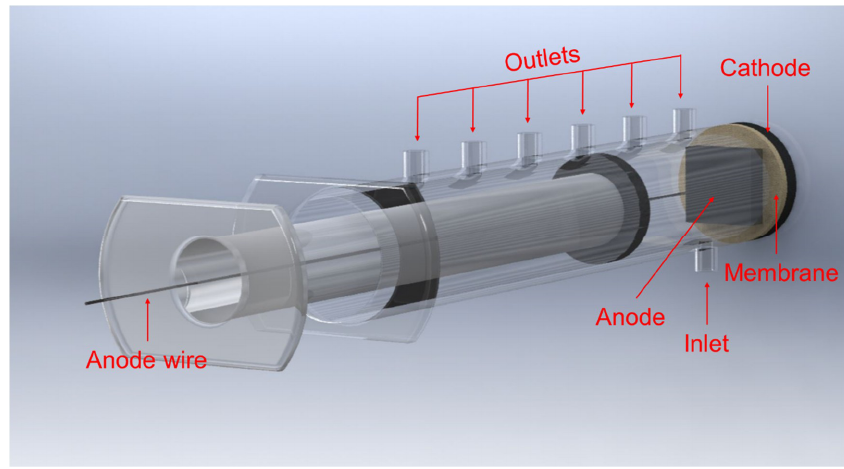
Figure 1. Computer Aided Design (CAD) image of a syringe microbial fuel cell (MFC) used in this study.